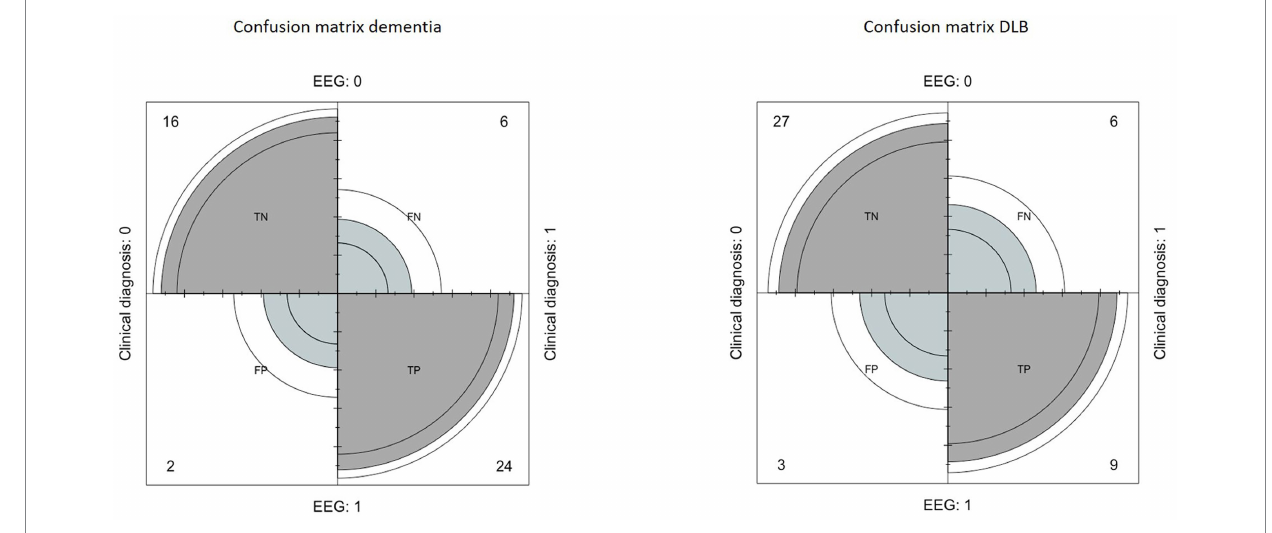
FIGURE 1 Left: confusion matrix built to evaluate the performance of EEG in the diagnosis of dementia, compared to clinical diagnosis. Right: confusion matrix built to evaluate the performance of EEG in the diagnosis of Lewy Body Dementia, compared to clinical